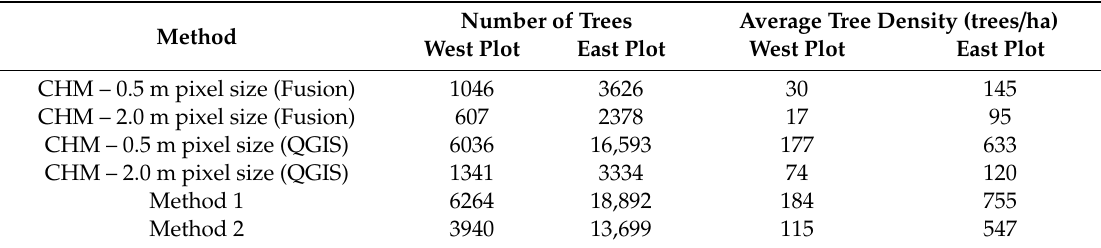
Table 3. Stem counting and density results on the whole area using the three applied methods.